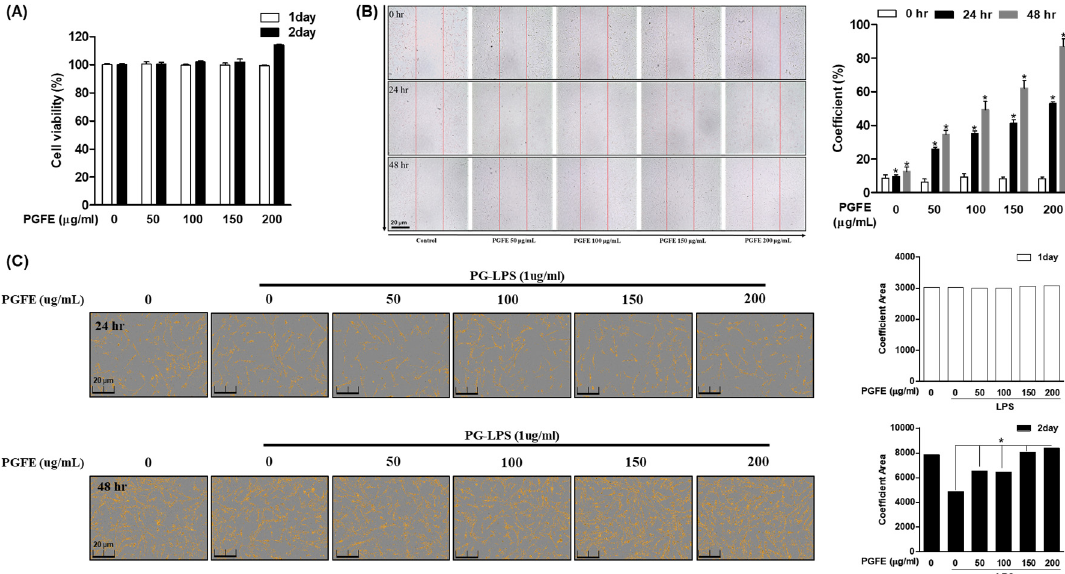
Figure 1. Panax ginseng fruit extract (PGFE) is not cytotoxic and showed a cell proliferation effect on HPDL cells. ( A ) HPDL cells were seeded at a density of 1 × 10 4 cells/well and treated with PGFE at the indicated concentrations (0–200 µg/mL) for 24 or 48 hr; then, afterwards, PGFE cytotoxicity was investgated by 3-(4,5-dimethylthiazol-2-yl)-2,5-diphenyltetrazoliumbromide (MTT) assay. ( B ) HPDL cells at a concentration of 5 × 10 5 cells/mL were seeded on a 6-well plate, scratched at regular intervals, treated with PGFE at the indicated concentration, and observed for 48 hr to measure the cell coefficient of the interval of scratches recovered by the cells. ( C ) The confluency of cells was determined using an IncuCyte imaging system. The Student’s t -test was used for statistical analysis. Differences were considered to be significant at values of * p < 0.05. Scale bars denoted 20 µm.